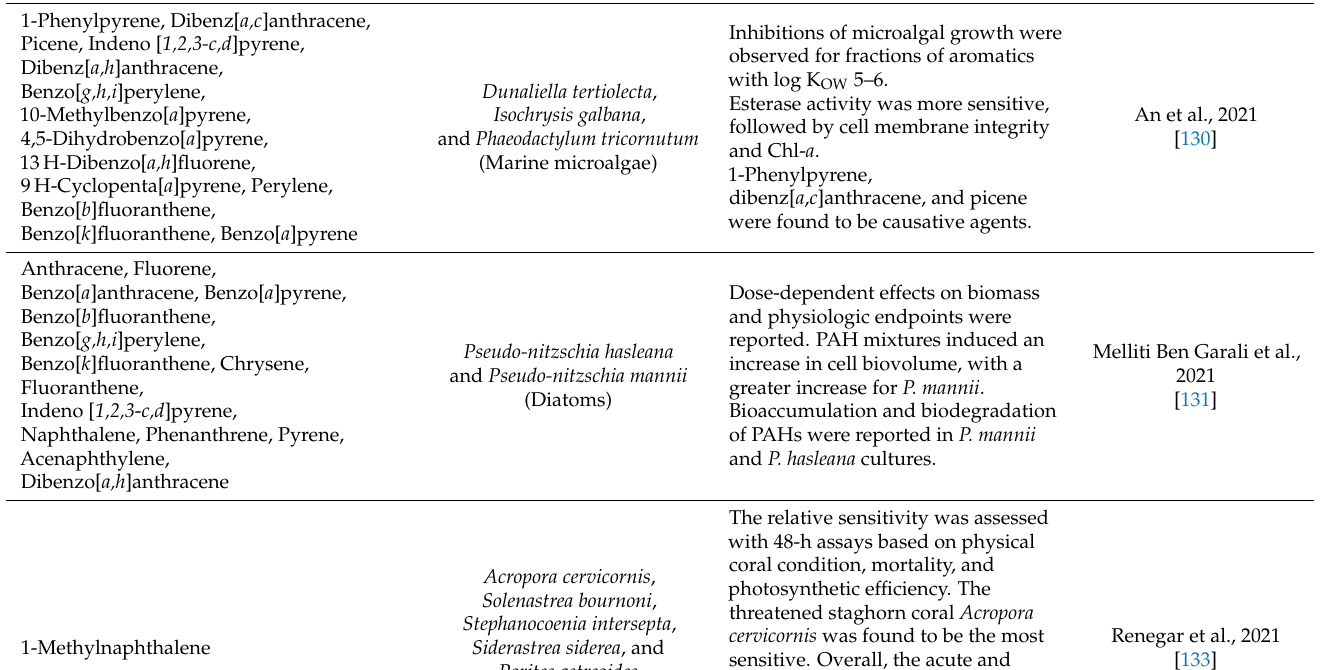
Table 3. Selected studies evaluating the toxicity of PAHs on marine plant and animal species. PAH (s) Tested